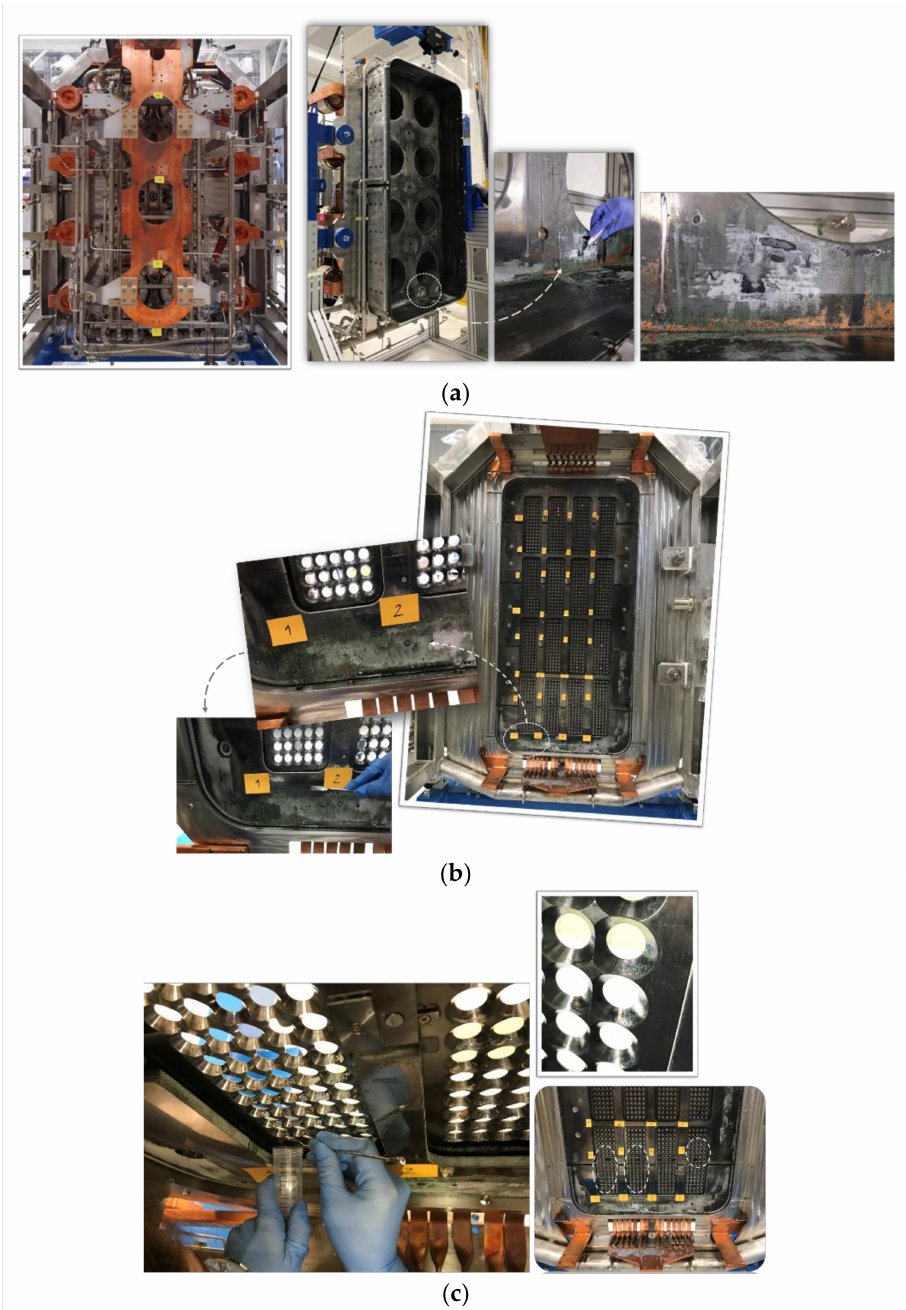
Figure 2. Compounds taken from ( a ) Driver Plate (the Rear Driver Plate is on the left, while the Plasma Driver Plate can be seen on the right); ( b ) Bias Plate; and ( c ) Plasma